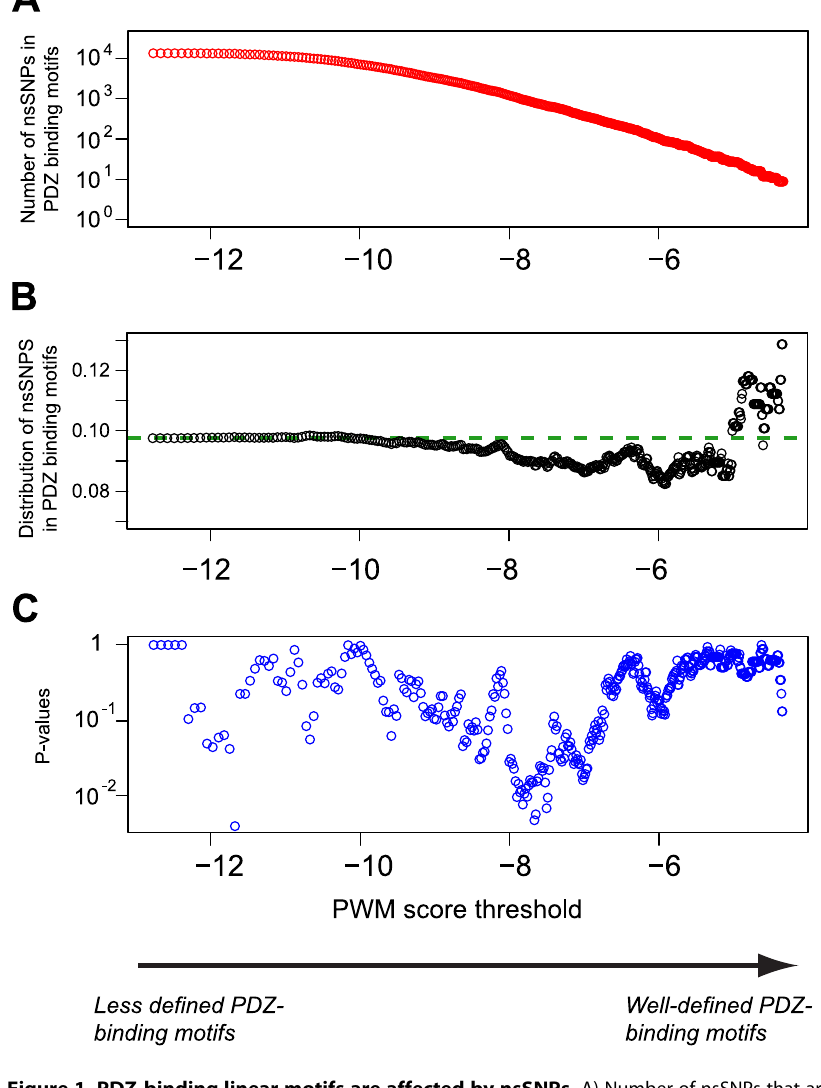
Figure 1. PDZ-binding linear motifs are affected by nsSNPs. A) Number of nsSNPs that are found in PDZ-binding motif containing C-termini for a wide range of thresholds on PWM scores to define PDZ-binding motifs. Higher threshold values (corresponding to more stringent definitions of PDZ-binding motifs) result in few C-termini being considered as containing a PDZ-binding motif, hence few nsSNPs falling in these motifs. B) Distribution of nsSNPs in PDZ-binding motifs, computed as the ration between the number nsSNPs shown in panel A and the total number of amino acids in PDZ-binding motif containing C-termini. For the highest thresholds ( .2 6), the number of nsSNPs falling in PDZ-binding motifs is not lower than expected. Then for thresholds between 2 6 and 2 9, it becomes slightly lower. For even lower thresholds, we tend to the expected distribution observed for all C-termini (9.9% of positions affected by nsSNPs, dashed line). C) The corresponding P-value assuming a uniform distribution of nsSNPs in all C-terminal segments (binomial